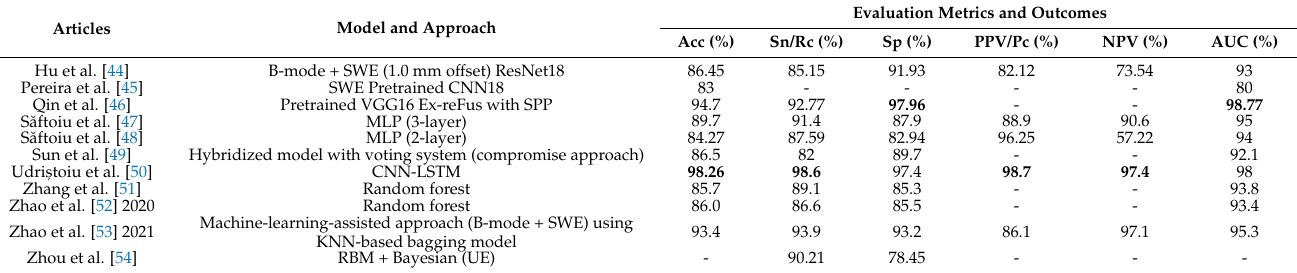
Table 4. Evaluation metric and outcome performance of the method with either the best or featured